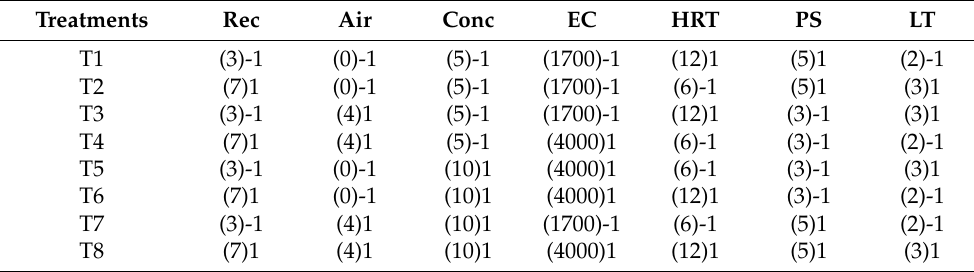
Table 2. Experimental matrix of a 2 7 − 4 fractional factorial design with the levels of the independent factors in eight